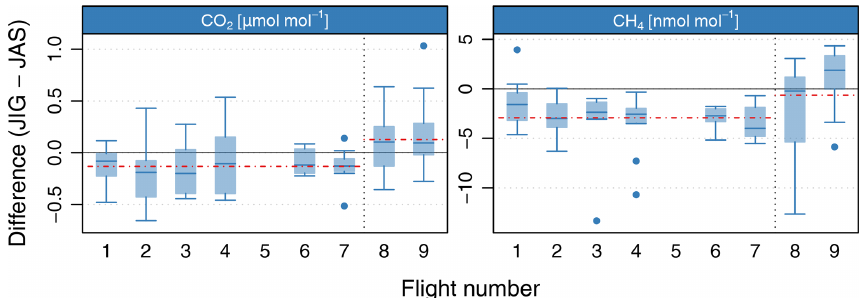
Figure 3. Comparison between JIG results and analysis of flasks collected during CoMet 1.0 aboard HALO. Data from the last two flights (separated by the dashed line) indicate a residual change in calibration, following an instrument malfunction. See text for